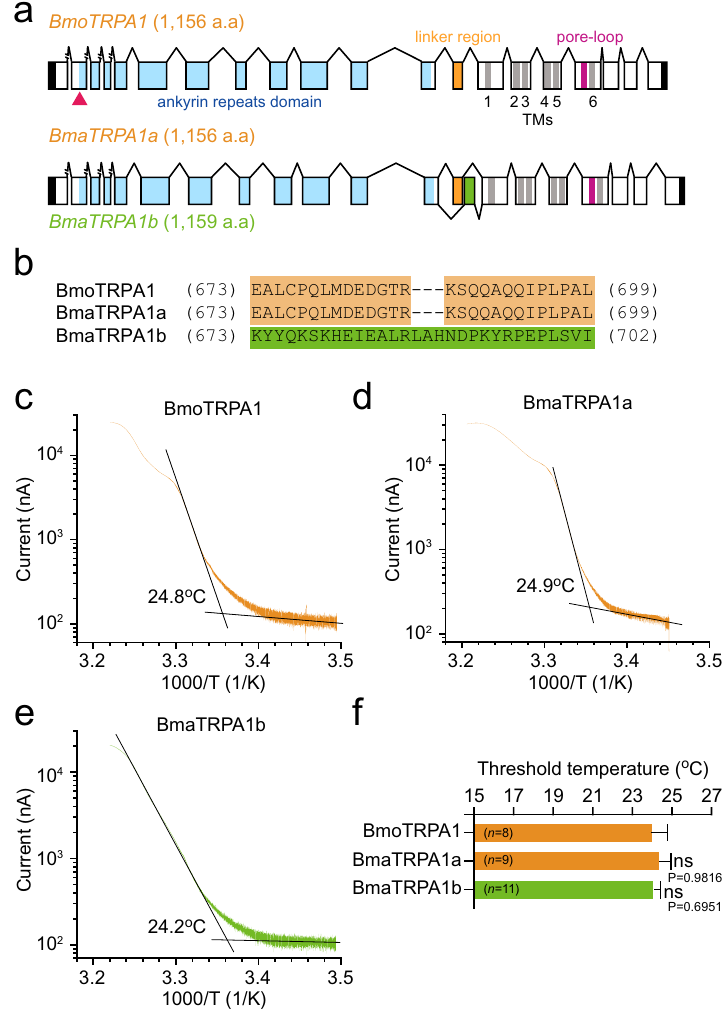
Figure 3. Cloning and functional analysis of Bombyx mori and B. mandarina TRPA1. ( a ) Schematic representations of the B. mori TRPA1 ( BmoTRPA1 ), B. mandarina TRPA1a ( BmaTRPA1a ), and TRPA1b ( BmaTRPA1b ). Boxes and lines represent exons and introns, respectively. Black, blue, orange, gray, and red boxes represent domains of untranslated regions, ankyrin repeat, linker region, transmembrane (1 ~ 6), and pore-loop, respectively. The red triangle indicates the TALEN target site. ( b ) Sequence alignment of the linker region between TRPA1s. ( c – e ) Arrhenius plots for the heat-induced BmoTRPA1, BmaTRPA1a, and BmaTRPA1b current shows a clear flex point in temperature dependency. Each temperature threshold for TRPA1 activation was defined as when the two linear-fitted lines crossed (i.e., a flex point). ( f ) Comparison of threshold temperature for each TRPA1. Each bar represents the mean ± SEM of 8–11 samples. Significant differences versus BmoTRPA1 were evaluated. ns,